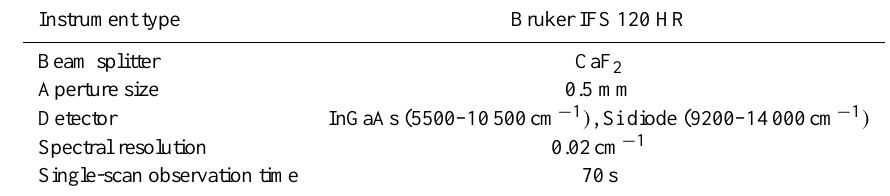
Table 1. Characteristics of the Tsukuba TCCON FTS.